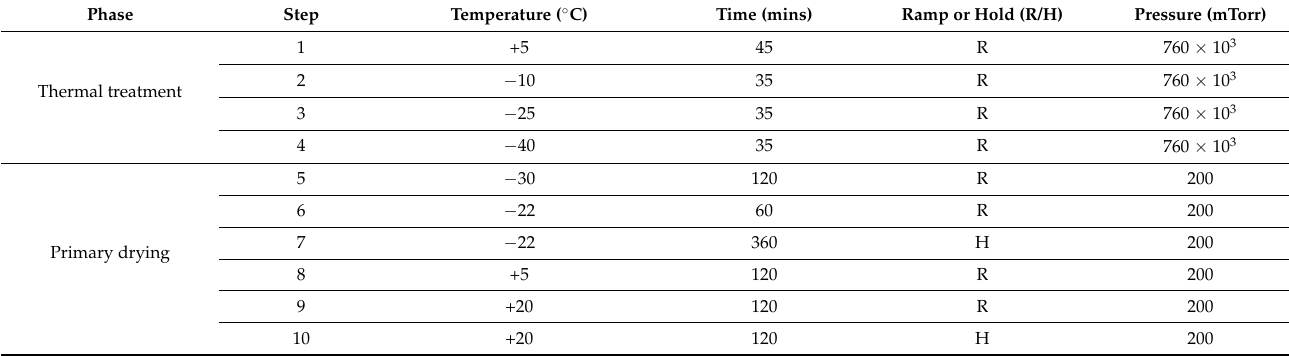
Table 1. Thermal treatment steps for shelf-based lyophilization protocol.